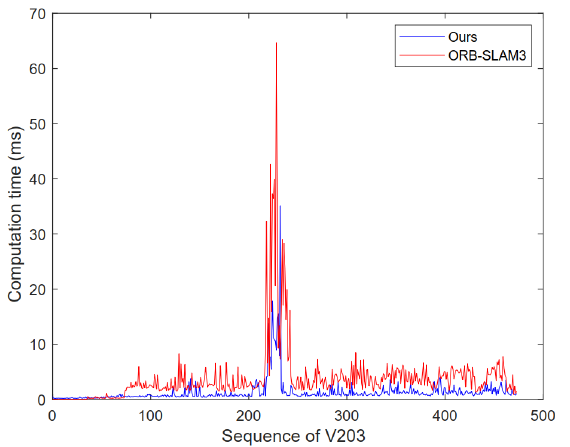
Figure 8. Computation time used to loop closure detection for each frame in V203.